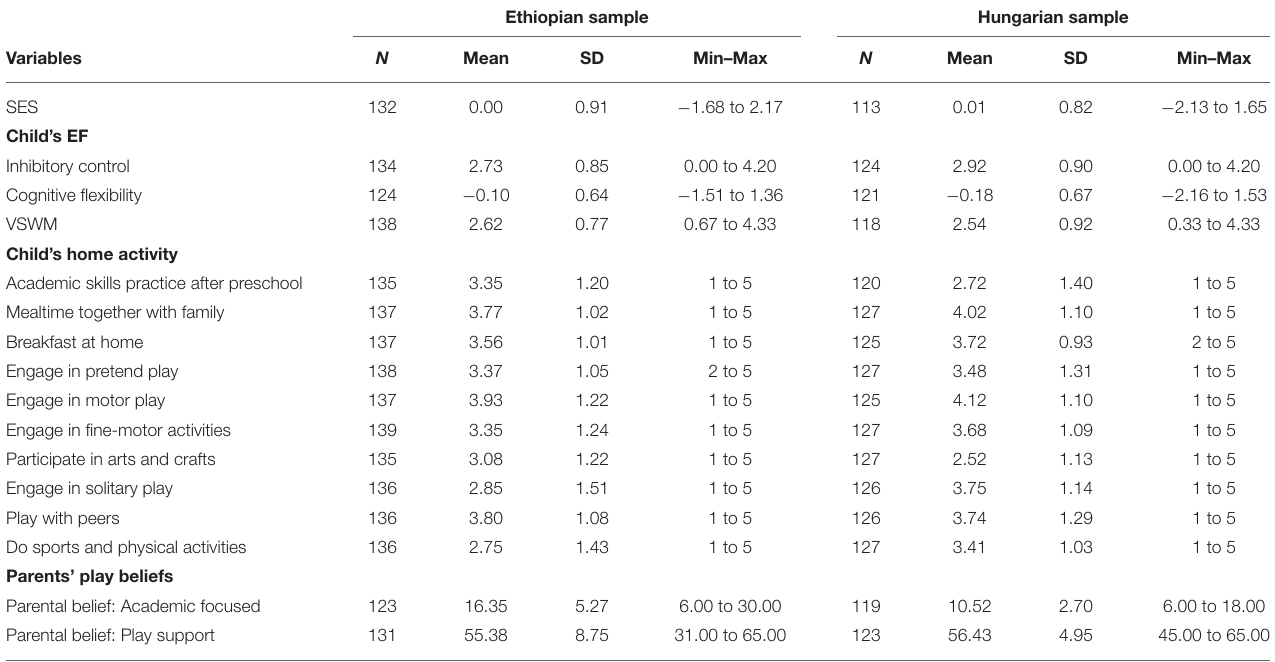
TABLE 2 | Descriptive statistics for EF and home experience measures in two samples.